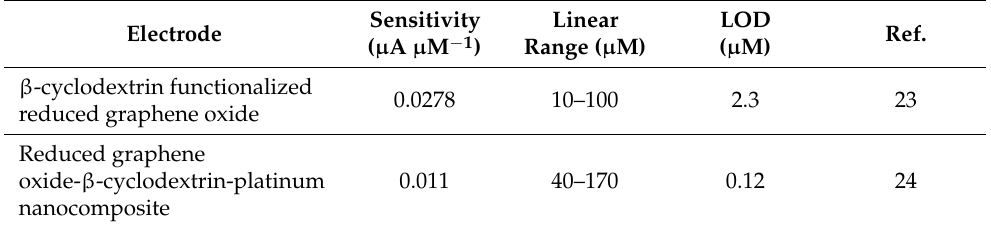
Table 2. Comparison of CD1-erGO/GCE with other reported modified electrodes containing both cyclodextrin and reduced graphene oxide for different